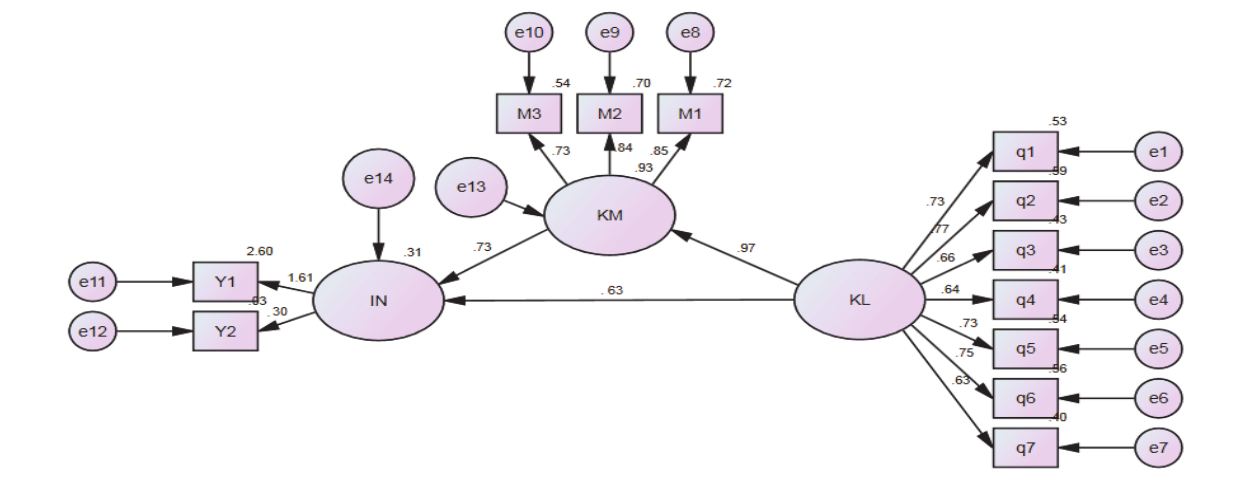
Fig. 2. The results of the implementation of the structural equation